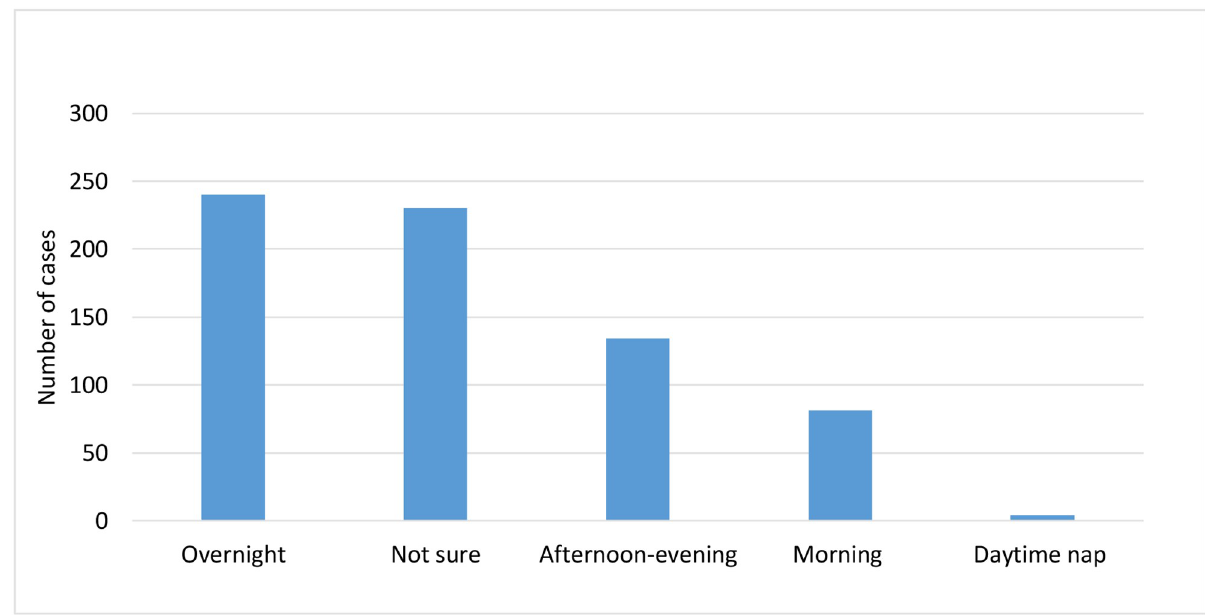
Fig 2. Women who had a stillbirth and their perception of timing of the death. Data are n = 689.